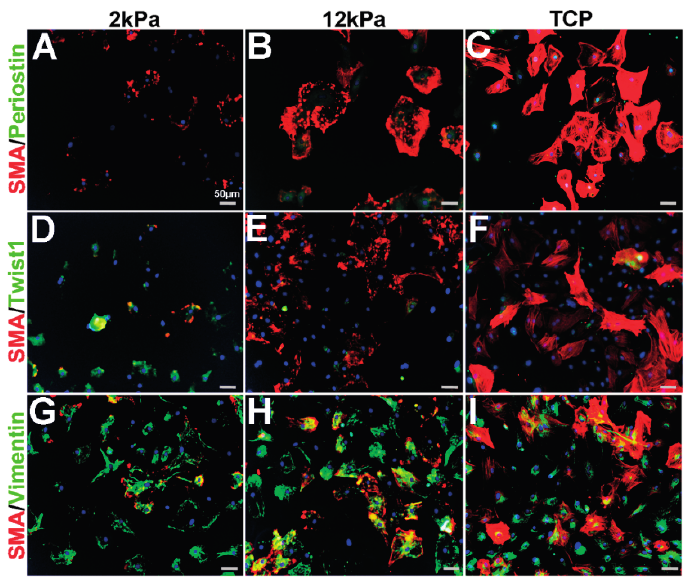
Figure 5. Expression profiles of rat mitral VICs cultured on increasing substrate stiffness. Immunohistochemistry to show expression of smooth muscle α -actin (SMA) with Periostin ( A – C ), Twist1 ( D – F )) and Vimentin ( G – I ) in isolated rat mitral VICs cultured on 3D nanofiber (polycaprolactone) scaffolds coated with collagen (Nanofiber Solutions) with substrate rigidities of 2 kPa ( A , D , G ), 12 kPa ( B , E , H ) and tissue culture plastic (TCP) ( C , F , I